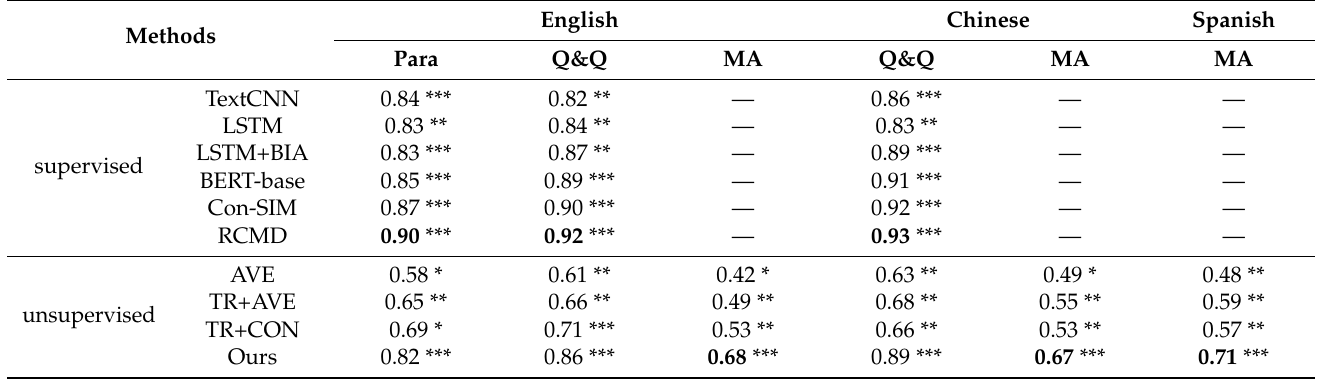
Table 4. The comparison of our calculation with the baseline algorithms (highest values in bold. ***, **, and * indicate three significant levels as 0.01, 0.05, and